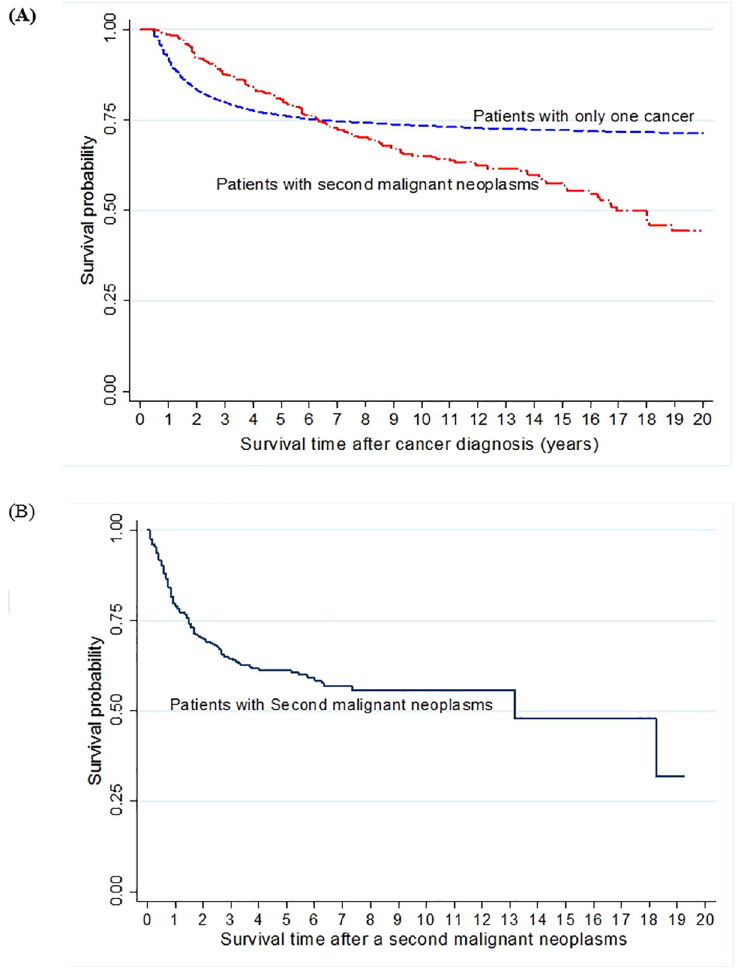
Fig 3. Survival probability of childhood cancer patients. (A) Survival probability of childhood patients with only one primary cancer and second malignant neoplasms. (B) Survival probability of childhood patients after second malignant neoplasms